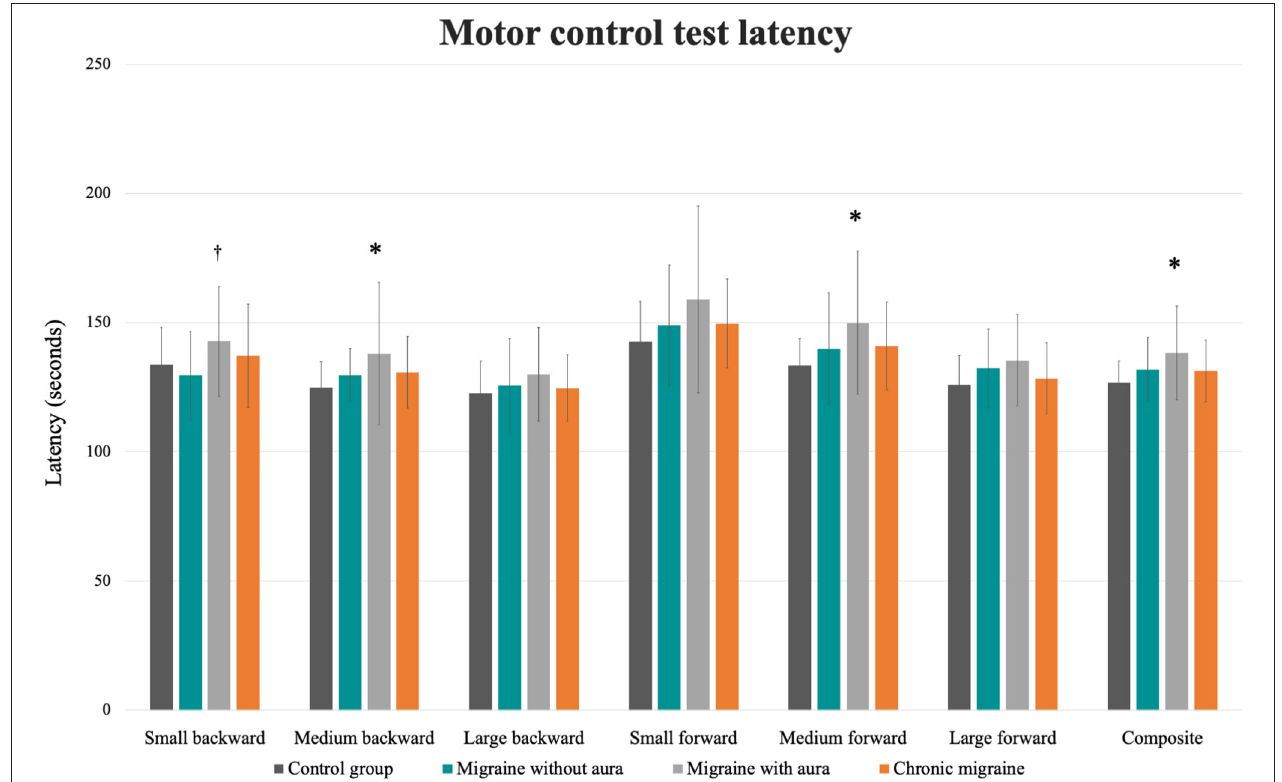
FIGURE 2 | Mean and standard errors of the latency (s) of each condition of the motor control test among patients with migraine with and without aura, chronic migraine, and controls. * p < 0.01 vs. control group; † p < 0.04 vs. migraine without